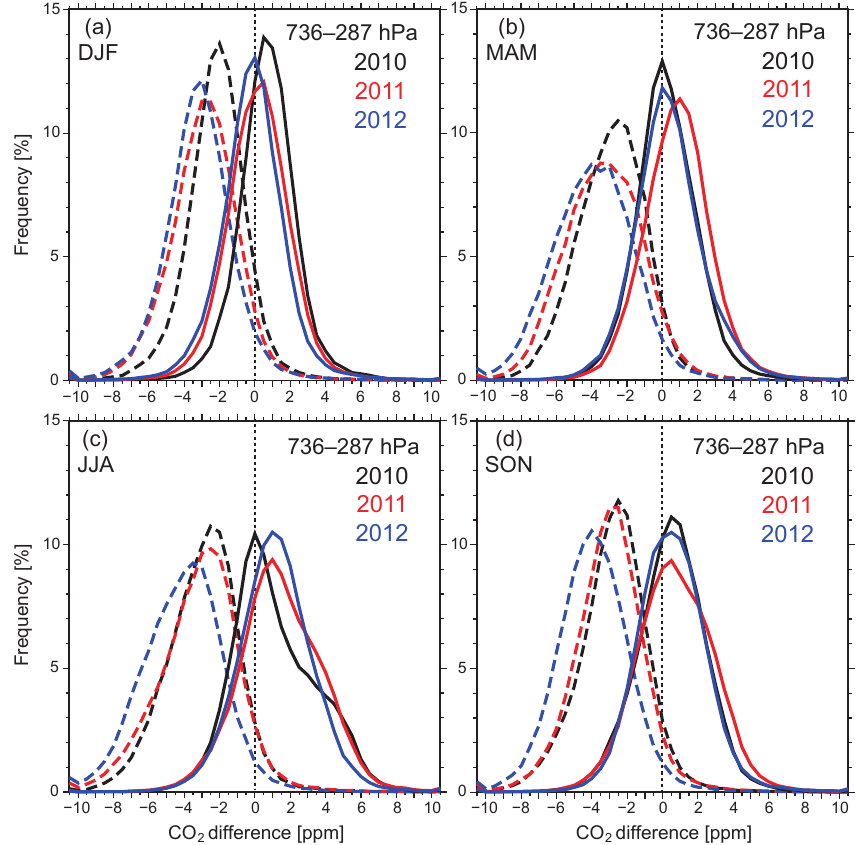
Figure 7. Frequency distributions of biases of monthly averaged GOSAT/TANSO-FTS TIR CO 2 data against monthly averaged NICAM-TM CO 2 data evaluated for each of retrieval layers from 736 to 287hPa for each 2.5 ◦ grid in the latitude range of 40 ◦ S–60 ◦ N. Monthly averaged TIR CO 2 averaging kernel functions were applied to NICAM-TM CO 2 data in each grid. Dashed and solid lines indicate the biases of the original TIR CO 2 data (no bias correction) and bias-corrected TIR CO 2 data, respectively. Black, red, and blue lines show results from 2010, 2011, and 2012,